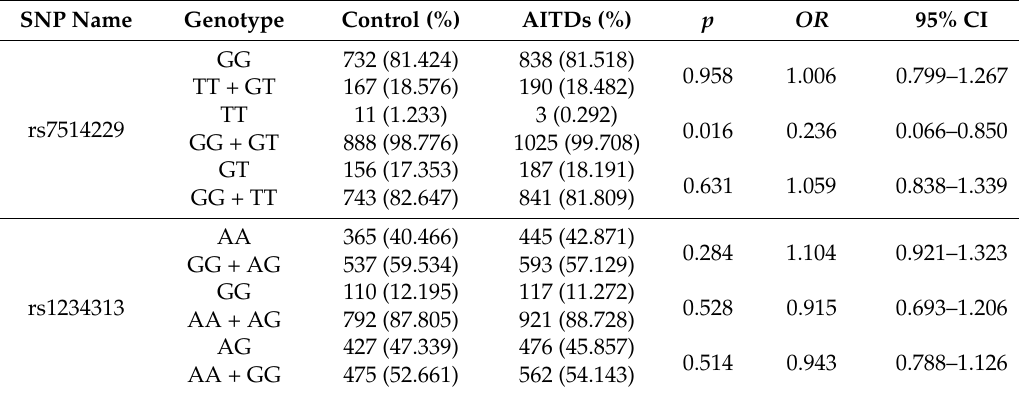
Table 3. Genotype frequency of TNFSF4 loci in AITDs patients and